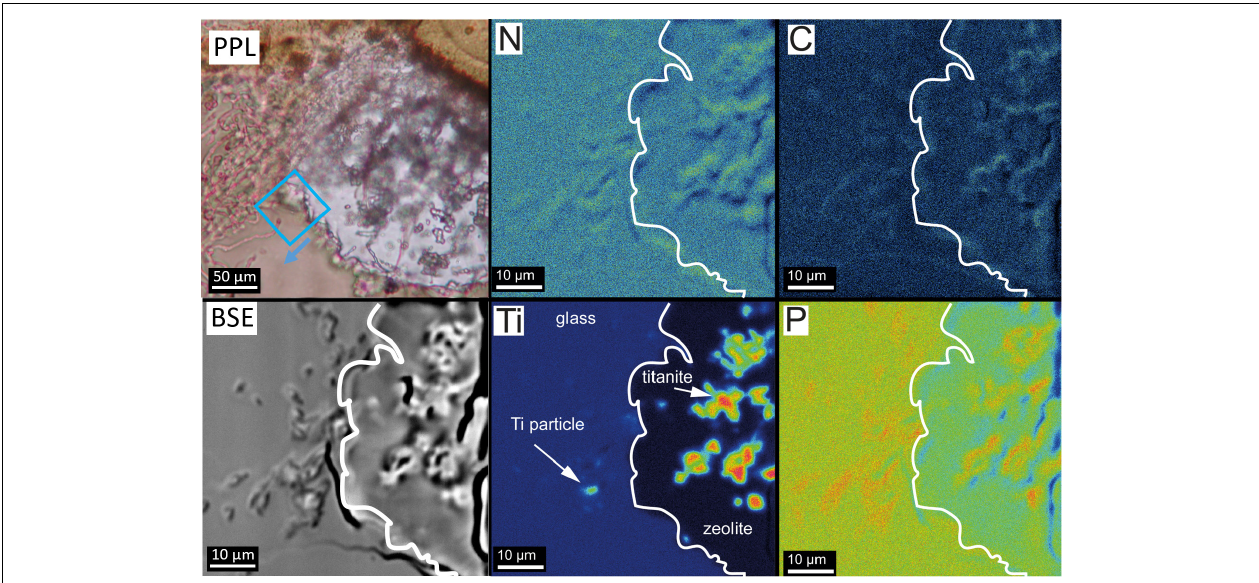
FIGURE 8 | Electron microprobe energy-dispersive X-ray maps of a representative area at the interface between unaltered basaltic glass and the zeolite alteration. The biologically important elements N, C, and P are associated with tubular textures in both unaltered basaltic glass, and Ti-rich titanite within the zeolite-mineralized zone. Isolated Ti-rich objects within the unaltered material (e.g., the small object marked by the white arrow in the Ti map) may represent early formed precursors to metamorphic titanite. A plane-polarized light (PPL) context image and backscattered electron (BSE) image are included for context, arrow indicates the up direction in the EPMA and BSE